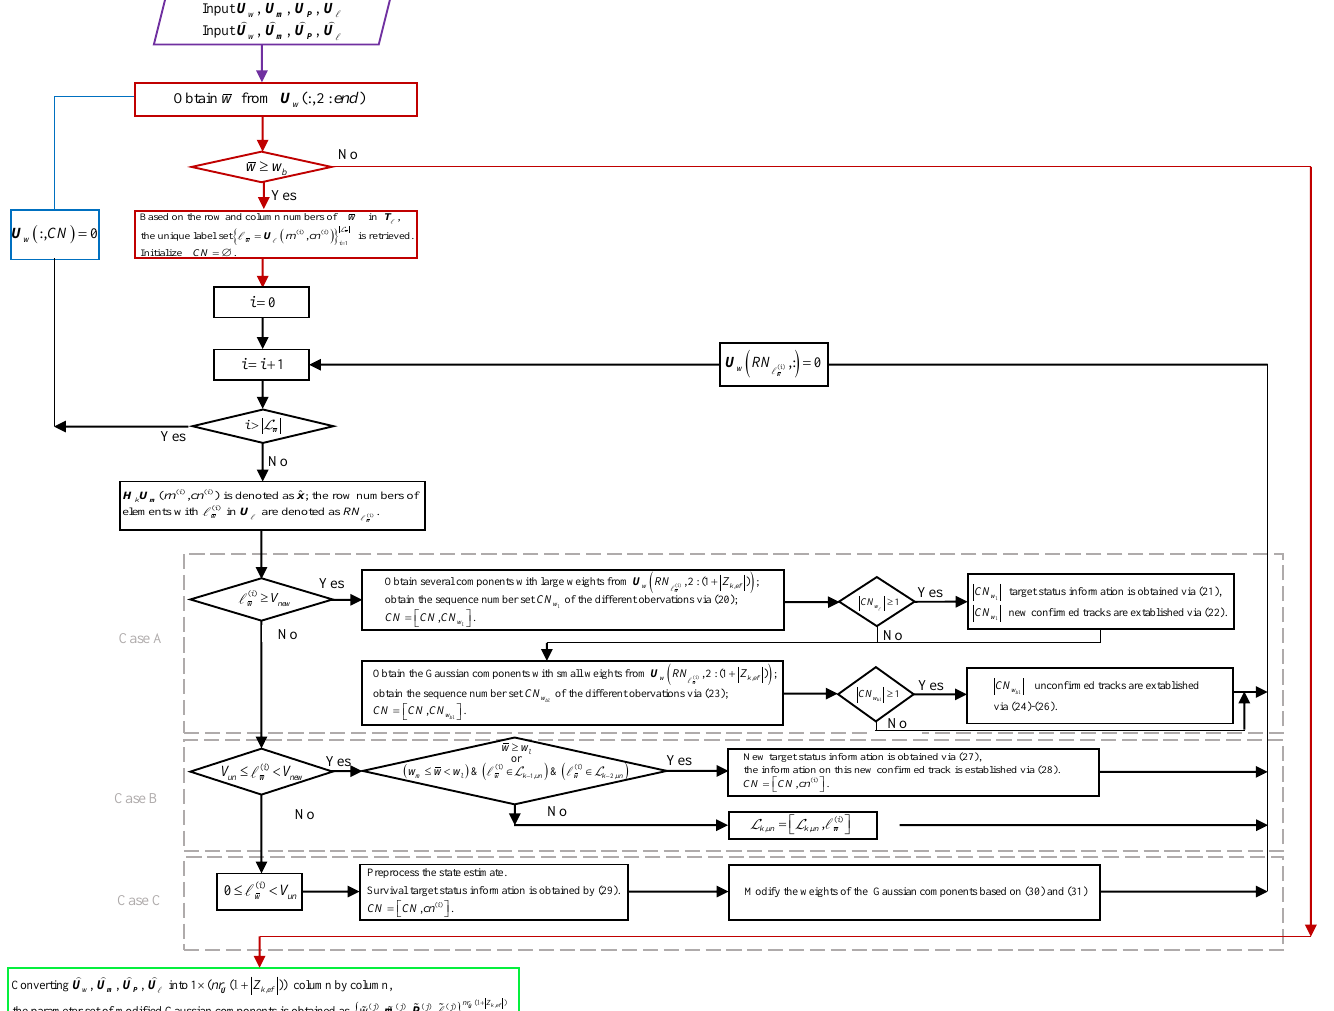
Figure A1. The overall procedure of the state extraction. The operations in the red boxes are step 1, the operations in the black boxes are step 2, the operation in the blue box is step 3, and the operations in the green box are step